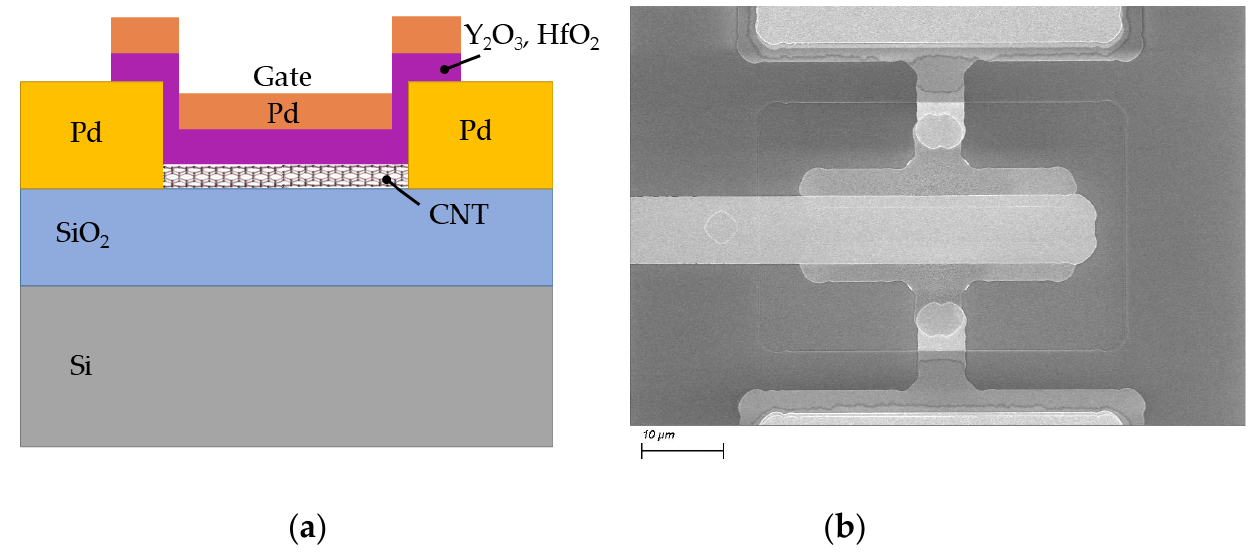
Figure 1. ( a ) Structure of the top-gate CNTFET; ( b ) SEM of the top-gate CNTFET.